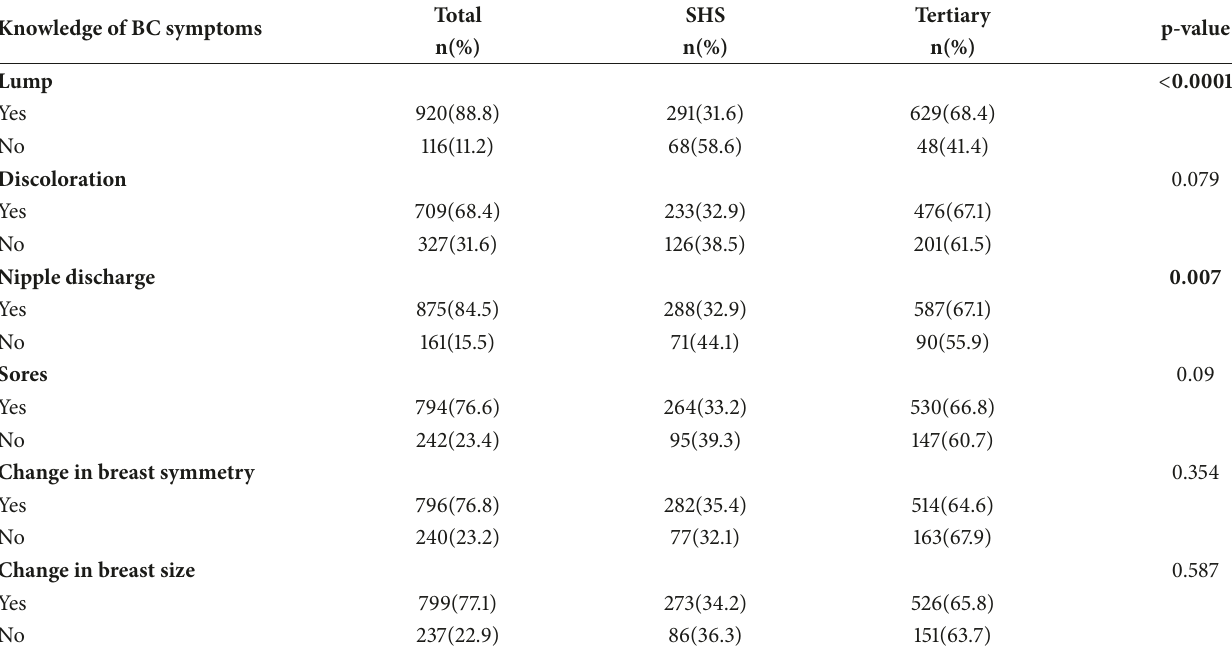
Table 3: Participants’ knowledge on symptoms of breast cancer stratified by their educational level.